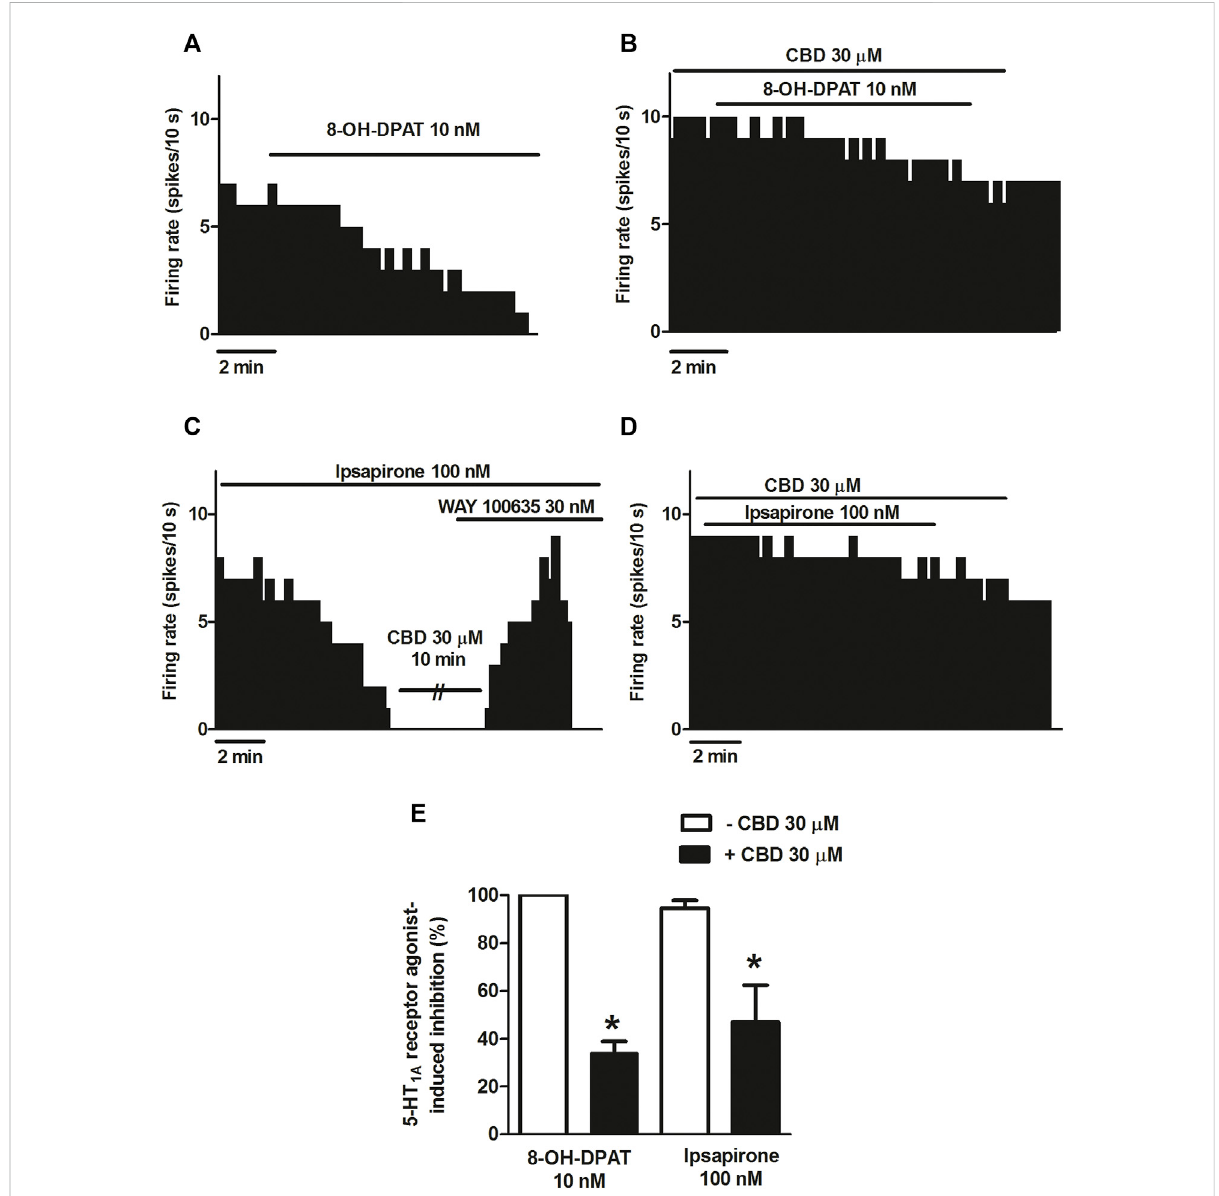
FIGURE 2 Effect of CBD on the selective 5-HT 1A receptor agonist-induced inhibition of the fi ring activity of DRN 5-HT cells. (A – D) Representative examples of fi ring rate recordings from DRN cells, which show the inhibition of the fi ring activity of 5-HT neurons by 8-OH-DPAT (10 nM) (A) , the blockade of 8-OH-DPAT (10 nM)-induced inhibition by CBD (B) , the inhibition of the fi ring rate of DRN 5-HT cells by ipsapirone (100 nM) and the effect of CBD (30 μ M) or the 5-HT 1A receptor antagonist WAY100635 (30 nM) on that inhibition (C) , and the blockade of the effect of CBD on the inhibition of the fi ring activity of DRN 5-HT neurons induced by ipsapirone (100 nM) (D) . Vertical lines refer to the integrated fi ring rate values (spikes per 10 s), and the horizontal lines represent the time scale. Drugs were perfused at the concentration and for the time indicated by the horizontalbars. (E) Barhistogramsshowingthepercentage ofinhibitionfromthebasal fi ringrate (mean±SEM)inducedby8-OH-DPAT(10 nM)and ipsapirone (100 nM) in the absence ( n = 5 and n = 13, respectively) and presence of CBD (30 μ M, n = 6 and n = 10, respectively). * p < 0.05 compared with the inhibition induced by 8-OH-DPAT (10 nM) or ipsapirone (100 nM) in the absence of CBD (30 μ M) by unpaired Student ’ s